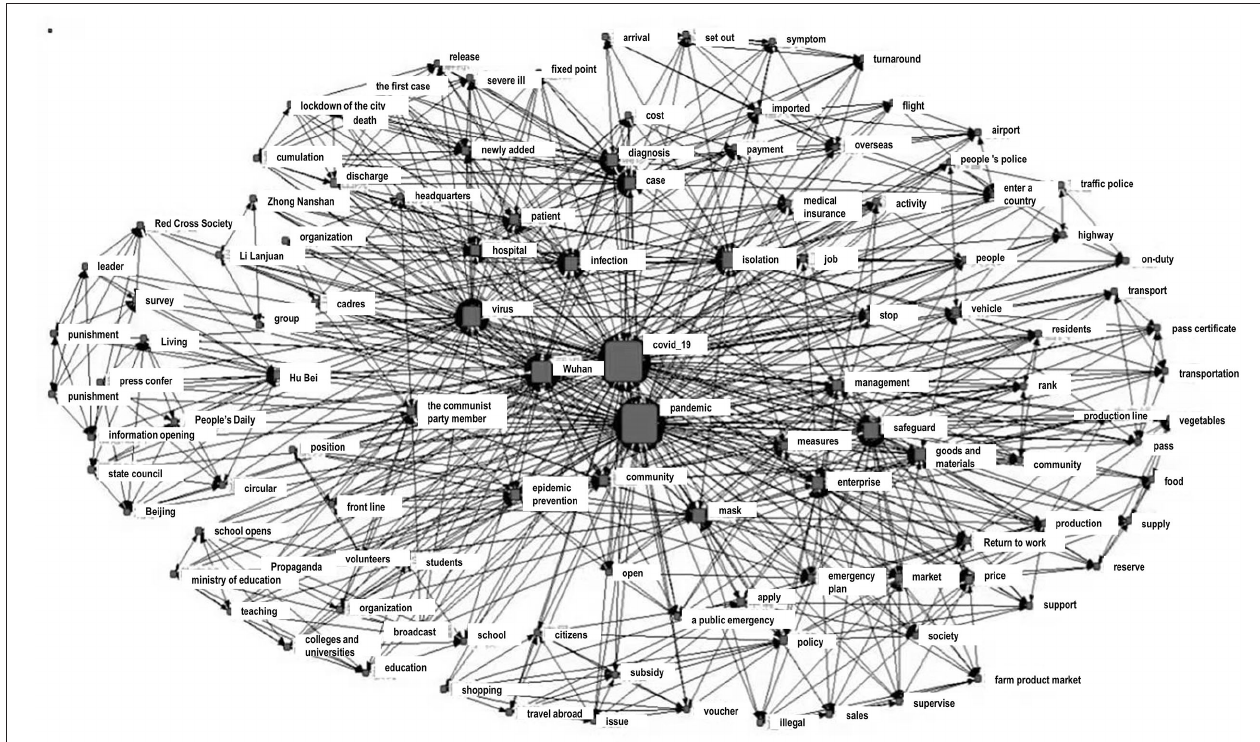
FIGURE 1 | Social network analysis of experience information